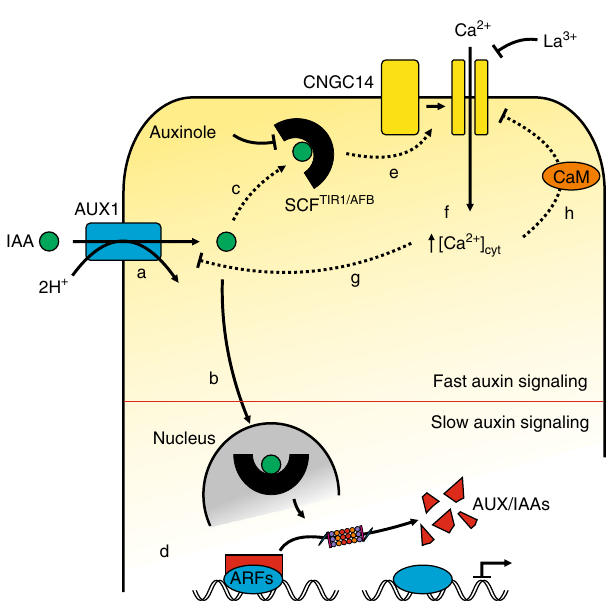
Fig. 7 Model for fast auxin signaling in root cells. Following its uptake via the high-af fi nity IAA/H + -symporter AUX1 (a) auxin is perceived by a nuclear (b) and a cytosolic fraction of the SCF TIR1/AFB receptor complex (c). Although nuclear perception results in changes at the transcriptional level via proteasomal degradation of Aux/IAA-class transcriptional repressors (d), a functional complex between the auxinole-sensitive cytosolic SCF TIR1/ AFB receptor and CNGC14 activates La 3 + -sensitive Ca 2 + -in fl ux upon auxin perception (e) resulting in elevated cytosolic Ca 2 + levels (f). Increased [Ca 2 + ] cyt feeds back on AUX1-mediated auxin transport, possibly through phosphorylation of AUX1 via Ca 2 + -dependent kinases (g) and on CNGC14 activity via the Ca 2 + -dependent interaction of CNGC14